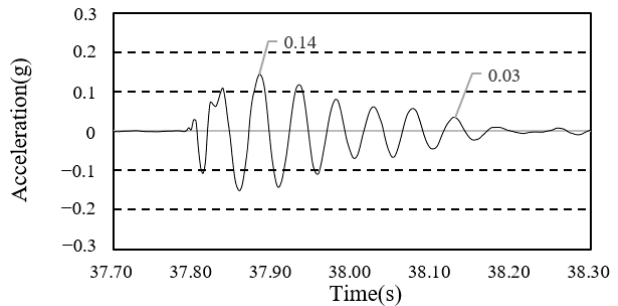
Figure 12. Damping ratio (framing completion).